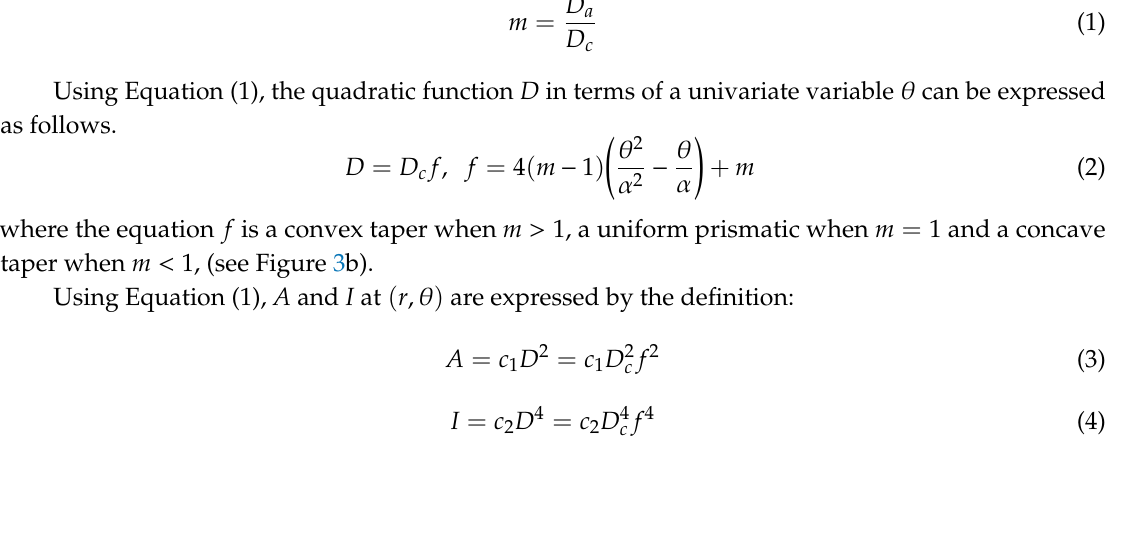
Figure 3. ( a ) Cross-sectional shape of arch and ( b ) variation function of depth (cid:1830) .